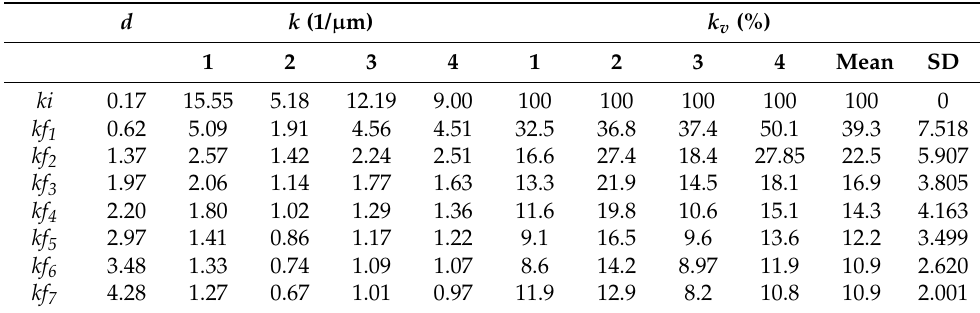
Table 1. Curvature measurements made at various distances d from the tip of the needle in different domains; k v values were obtained following Equation